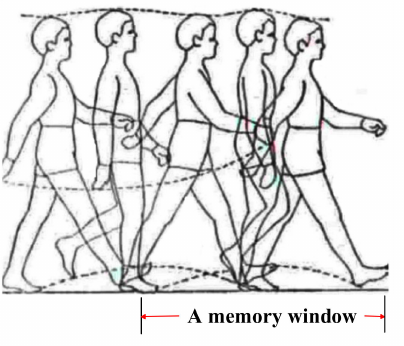
Figure 4. A memory window of the limited memory weighted